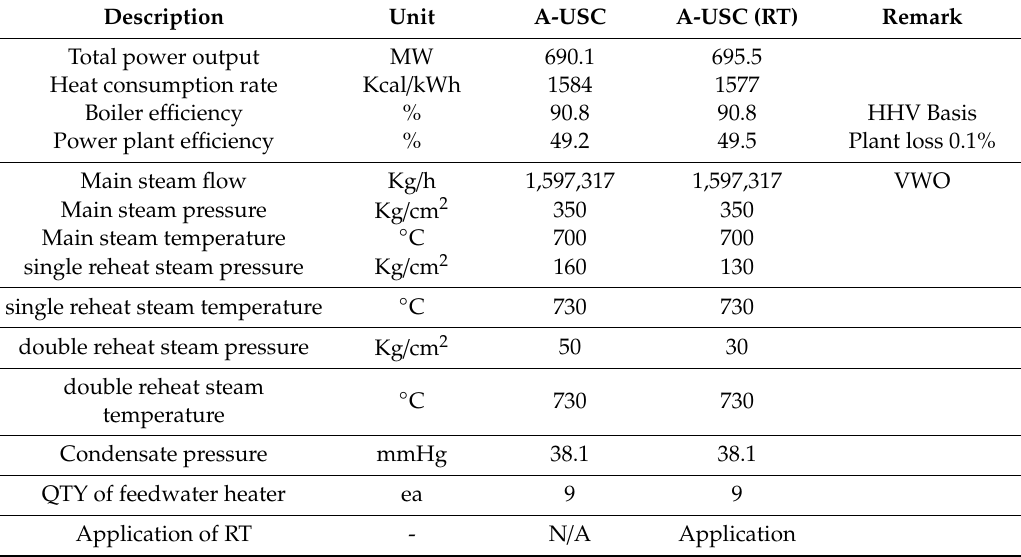
Table 9. Comparison of operating conditions and performance of A-USC with and without RT.